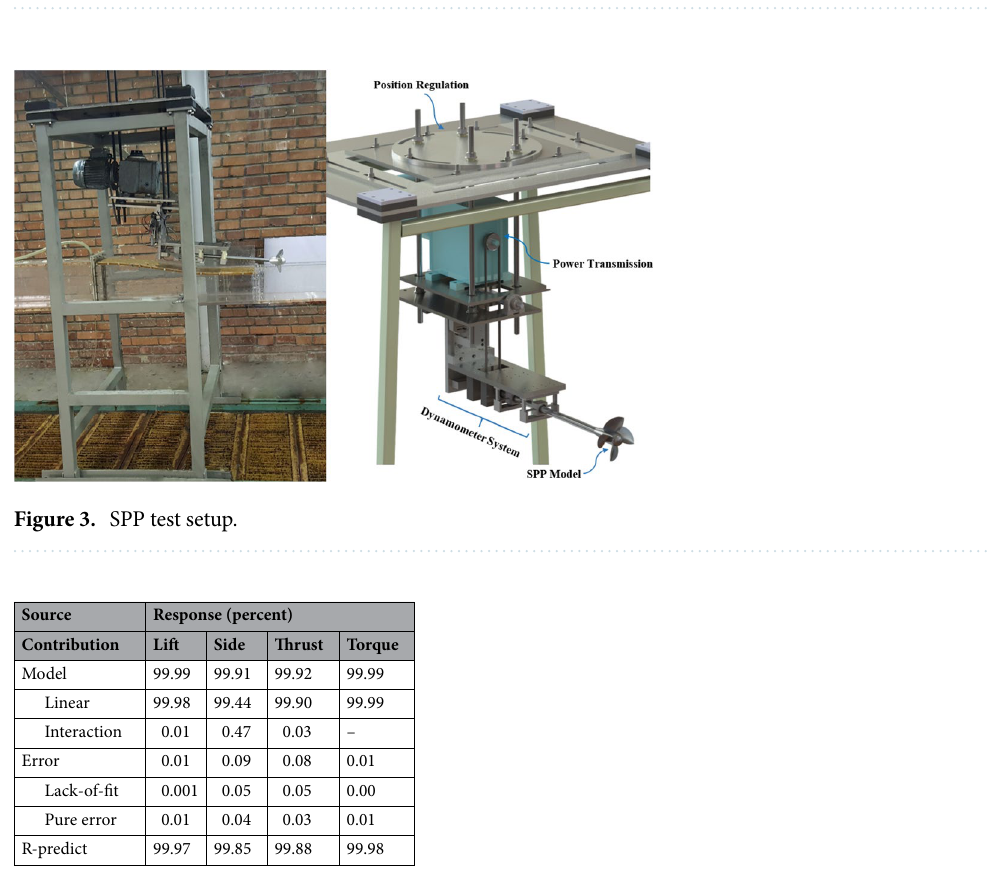
Figure 2. Open-section water tunnel at IUST.